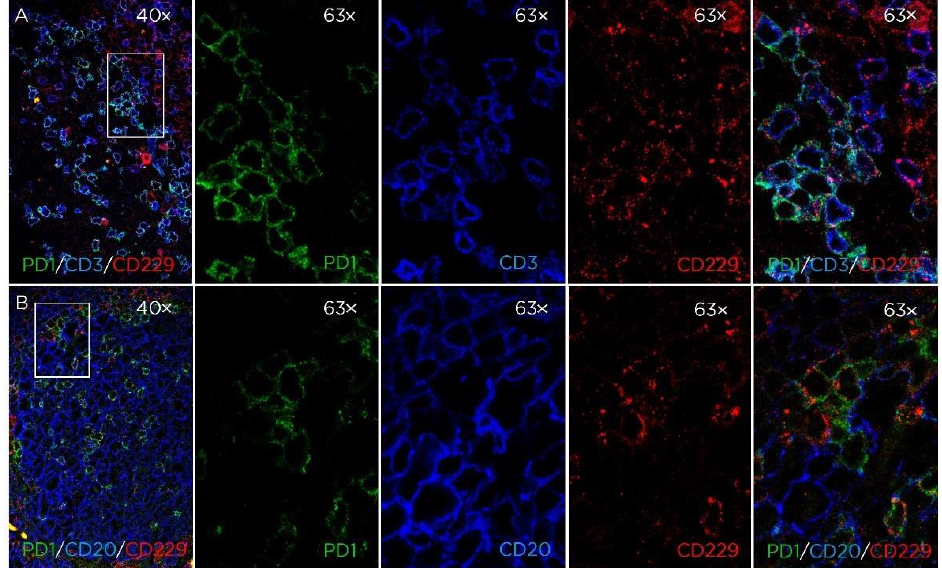
Figure 2. Expression of CD229 in tonsil GC. Triple color immunofluorescence of tonsil GC. ( A ) PD1 (green), CD3 (blue), and CD229 (red); ( B ) PD1 (green), CD20 (blue), and CD229 (red) (magnification: 40 × and 63 ×